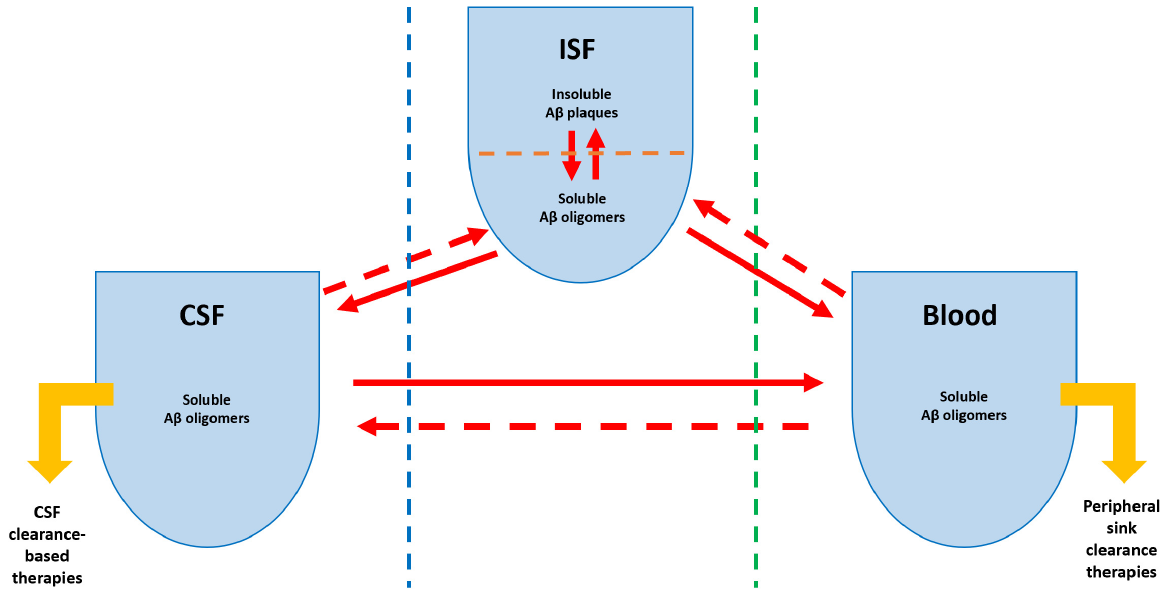
Figure 1. The schematic representation of the “three-sink therapeutic strategy” with the focus on amyloid-beta (A β ) dynamics (modified from the work by Menendez-Gonzalez et al. [33]). The green line represents the blood − brain barrier; the blue line represents the brain − cerebrospinal fluid (CSF) barrier; the full red arrows indicate the clearance/efflux direction of A β ; the dotted red arrows indicate the influx direction of A β ; the yellow arrows indicate therapeutic strategies.